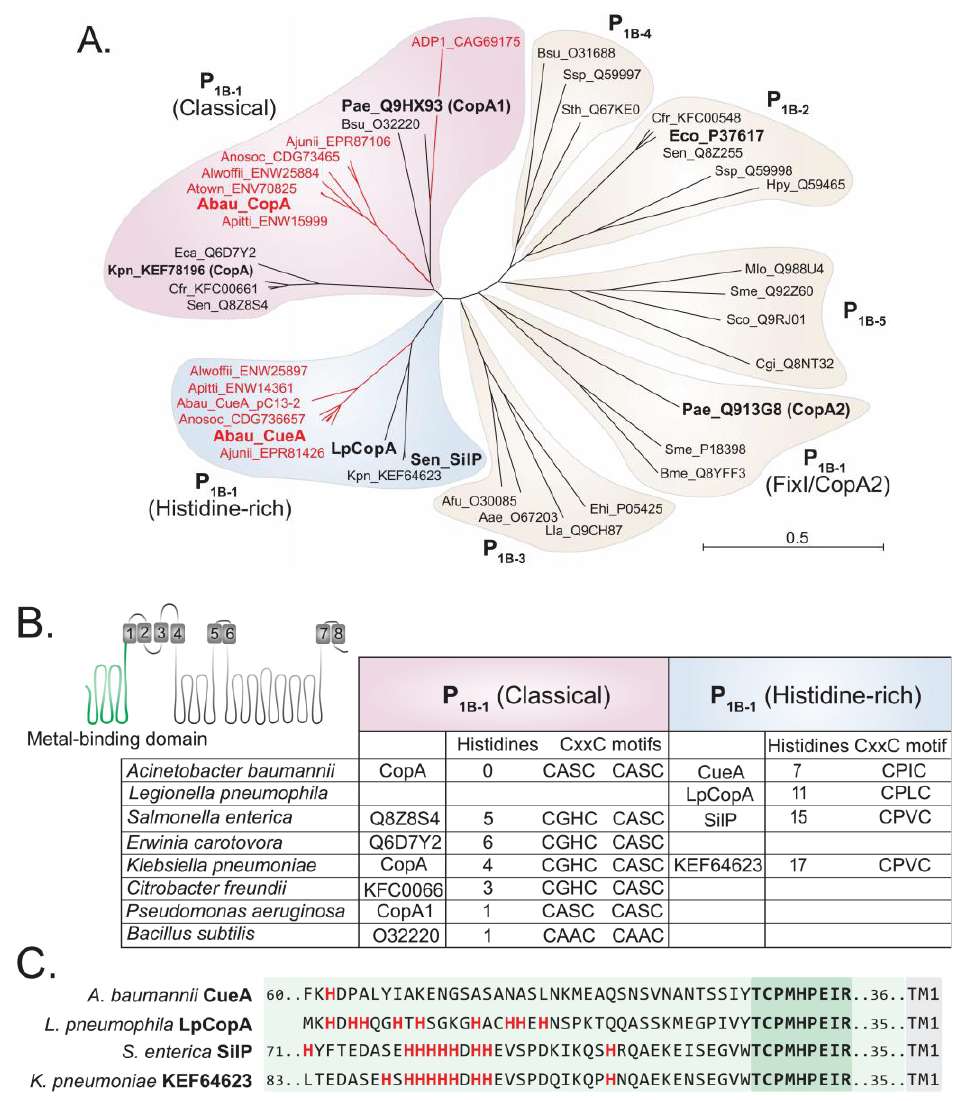
Figure 1. The P 1B-1 ATPases display significant sequence variation. ( A ) Phylogenetic analysis of the P-type ATPases, including members of the P 1B-1 (classical, FixI/CopA2, and histidine-rich), P 1B-2 , P 1B-3 , P 1B-4 , and P 1B-5 subgroups; ADP1, Acinetobacter baylyi ; Aea, Aquifex aeolicus ; Afu, Archaeoglobus fulgidus ; Ajunii, Acinetobacter junii ; Alwoffii, Acinetobacter lwoffii ; Anosoc, Acinetobacter nosocomialis ; Apittii, Acinetobacter pittii ; Atown, Acinetobacter towneri ; Bme, Brucella melitensis ; Bsu, Bacillus subtilis ; Cgl, Corynebacterium glutamicum ; Crf, Citrobacter freundii ; Eco, Escherichia coli ; Ehi, Enterococcus hirae ; Hpy, Helicobacter pylori ; Kpn, Klebsiella pneumoniae ; Lla, Lactococcus lactis ; LpCopA, Legionella pneumophila ; Mlo, Mesorhizobium loti ; Pae, Pseudomonas aeruginosa ; Pat, Pectobacterium atrosepticum ; Sco, Streptomyces coelicolor ; Sen, Salmonella enterica ; Sme, Sinorhizobium meliloti ; Sth, Symbiobacterium thermophilum ; Ssp, Synechocystis sp.; Sty, Salmonella enterica Typhy. All P-type ATPases from Acinetobacter are depicted in red and those functionally characterised are in a larger font. ( B ) Cartoon model of a P 1B-1 ATPase is depicted with its eight transmembrane domains. The model serves to highlight the position of the N-terminal metal-binding domain (in green). The table presents data of the N-terminal metal-binding domain of the classical and histidine-rich P 1B-1 ATPases only, showing the total number of histidine residues and the presence of the CxxC motifs. ( C ) The 40 amino acids at the N-terminal side of the conserved “TCPMHPEIR” domain (dark green shading) of the four histidine-rich P 1B-1 ATPases are displayed (light green shading). The first transmembrane domain (TM1) starts 35 or 36 amino acids (light green shading) towards the C-terminal end from the “TCPMHPEIR” domain. All histidine residues are displayed in bold and red.